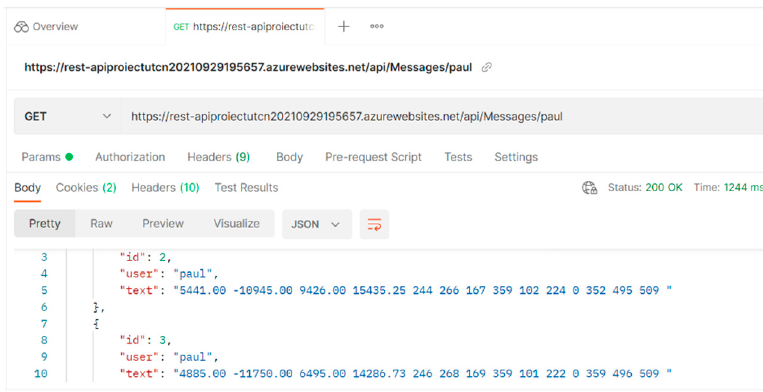
Figure 9. The online database content, resembling the data acquired with gait monitoring physiograph.